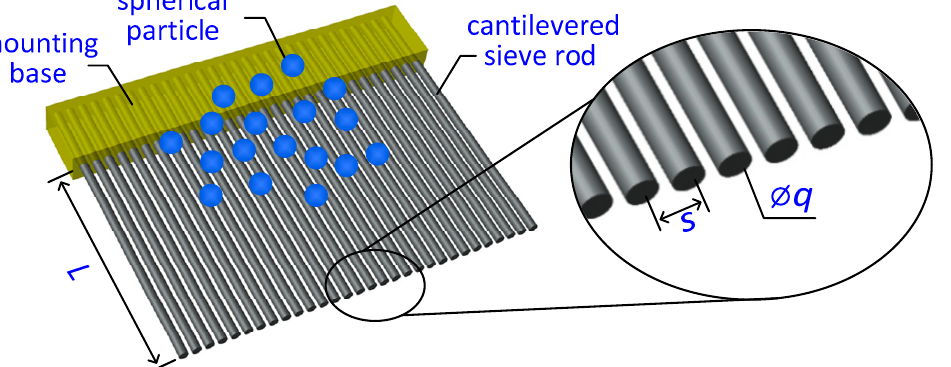
Figure 1. Mechanical structure of a cantilevered vibrating sieve (CVS).